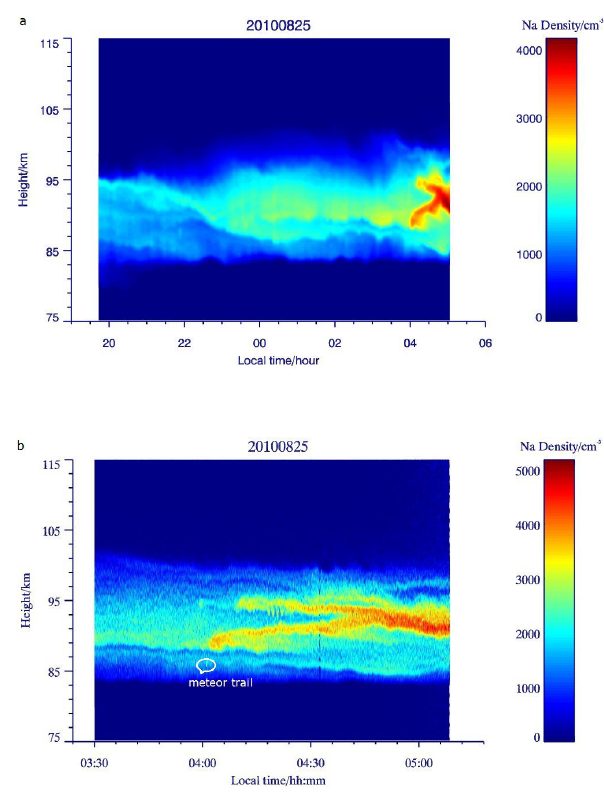
Fig. 5. Na density variations with time and height observed at dif- ferent time resolutions on the night of 25 August 2010: (a) 5min; (b)